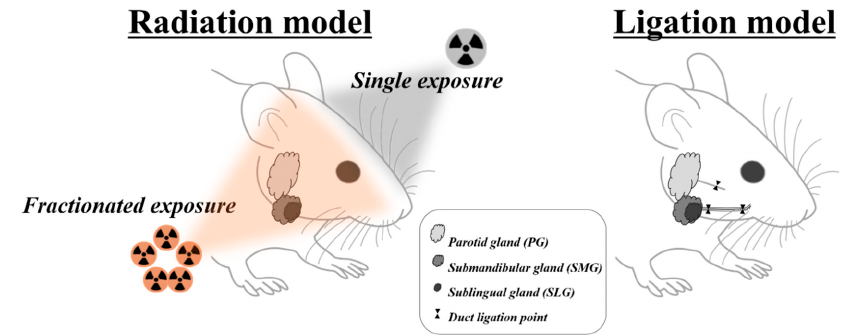
Figure 1. Overview of animal models mimicking radiotherapy- and duct obstruction–induced salivary gland damage.